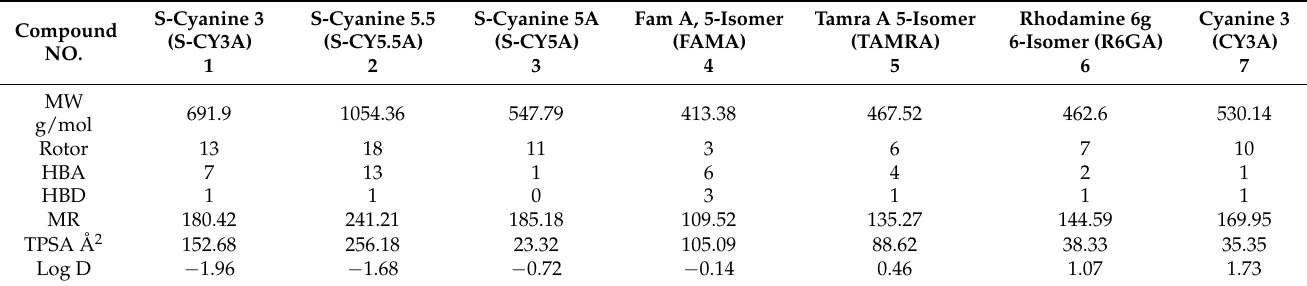
Table 4. Molecular descriptors of the fluorescent compounds and the experimentally determined Log D values. Compound